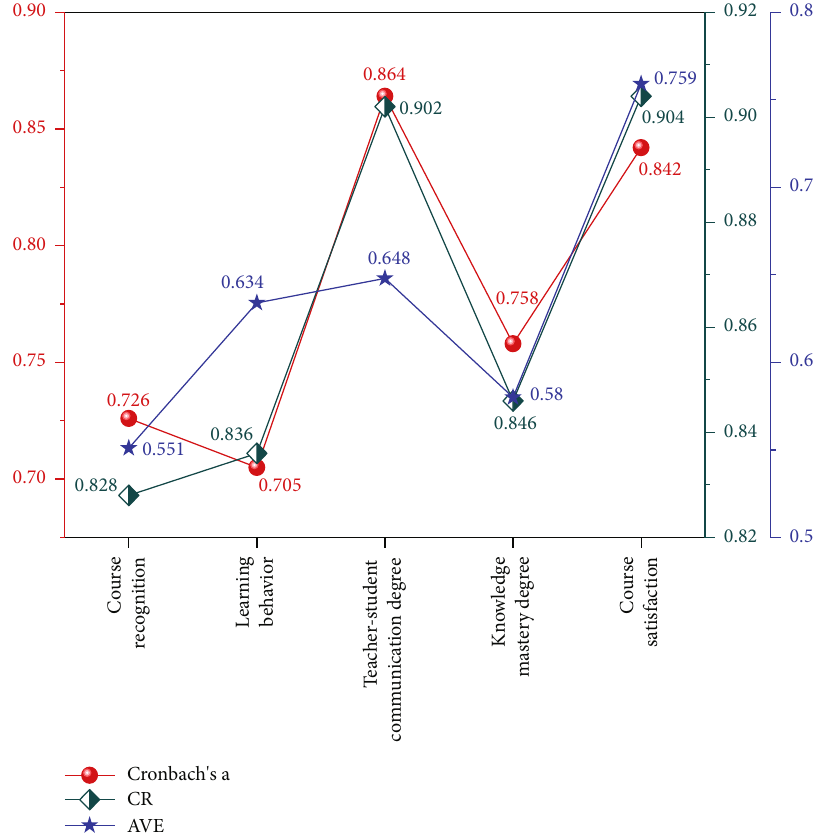
Figure 6: Correlation coe ffi cient of latent variables in the